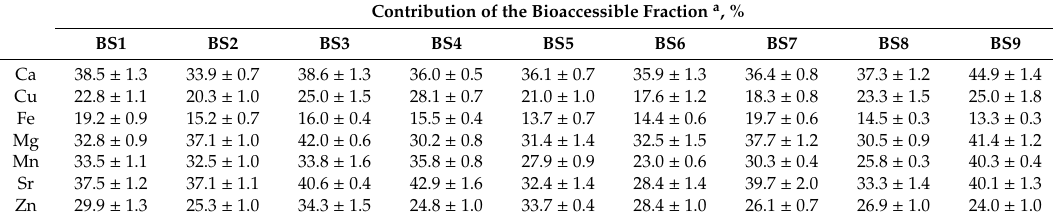
Table 6. Percentage contributions of the bioaccessible fraction of elements from all analyzed birch saps